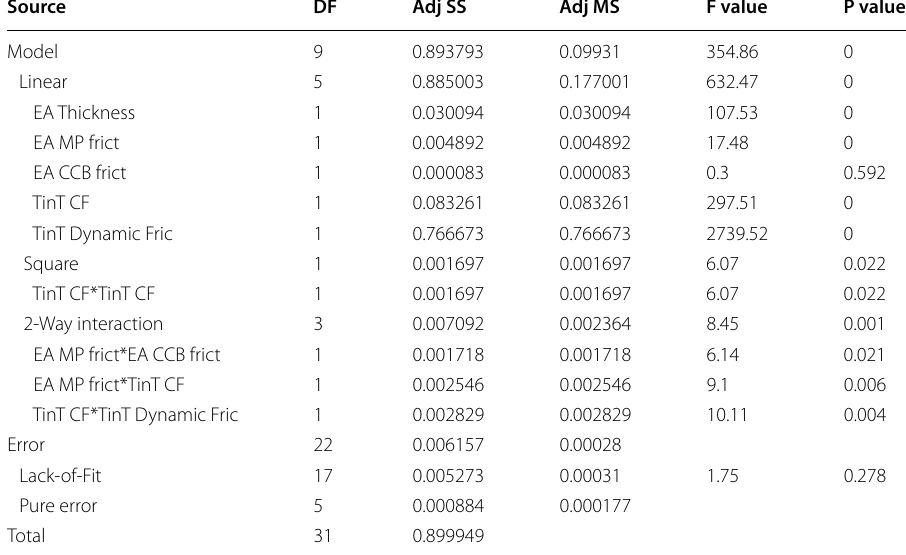
Table 3 ANOVA for 19.5 mm collapse